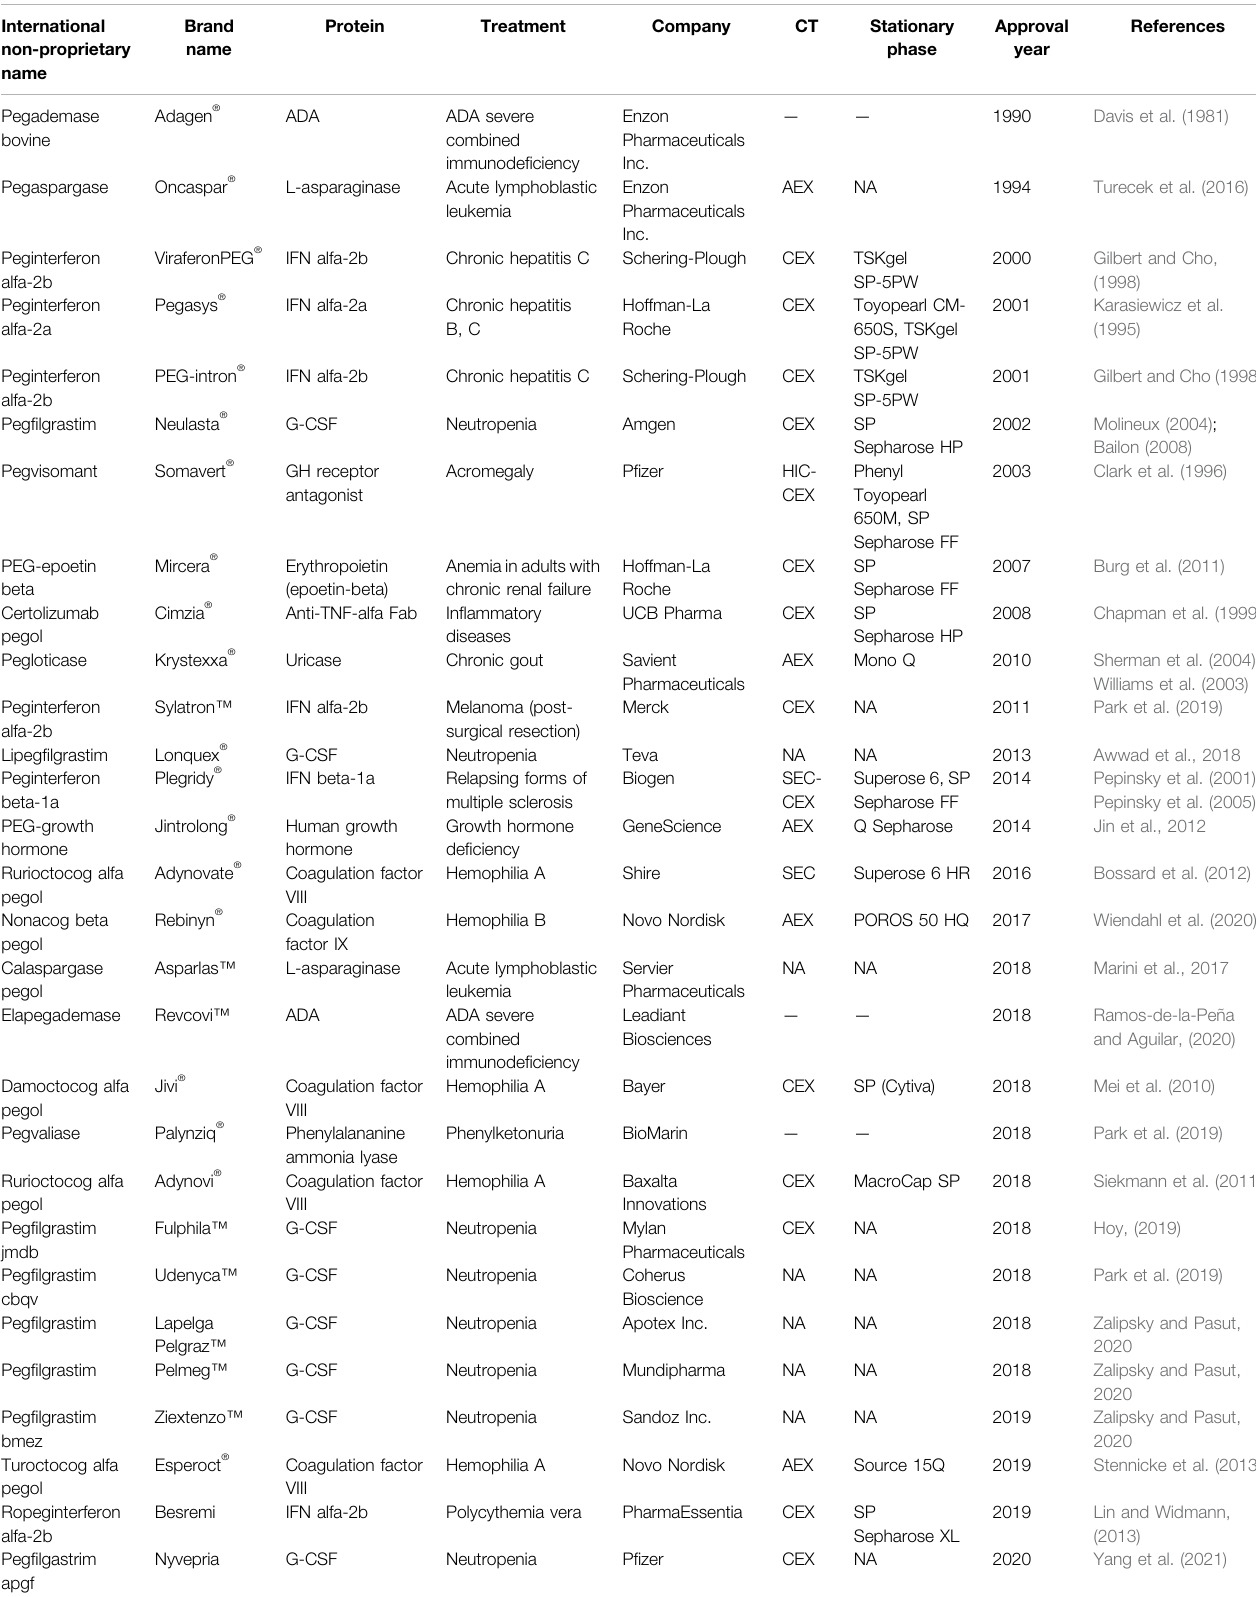
TABLE 1 | Approved PEGylated